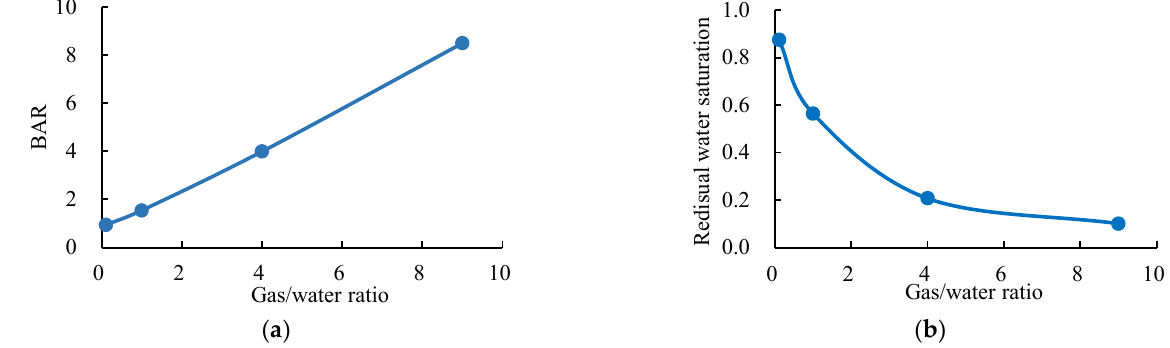
Figure 13. Effect of the gas/water ratio on ( a ) BAR and ( b ) residual water saturation.